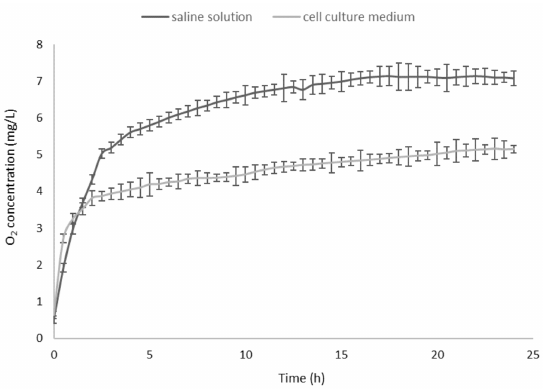
Figure 2. In vitro oxygen release kinetics from oxygen-loaded cyclic nigerosyl-nigerose solution (NaCl 0.9% w / v ) in the two receiving phases (NaCl 0.9% w / v and cell culture medium).